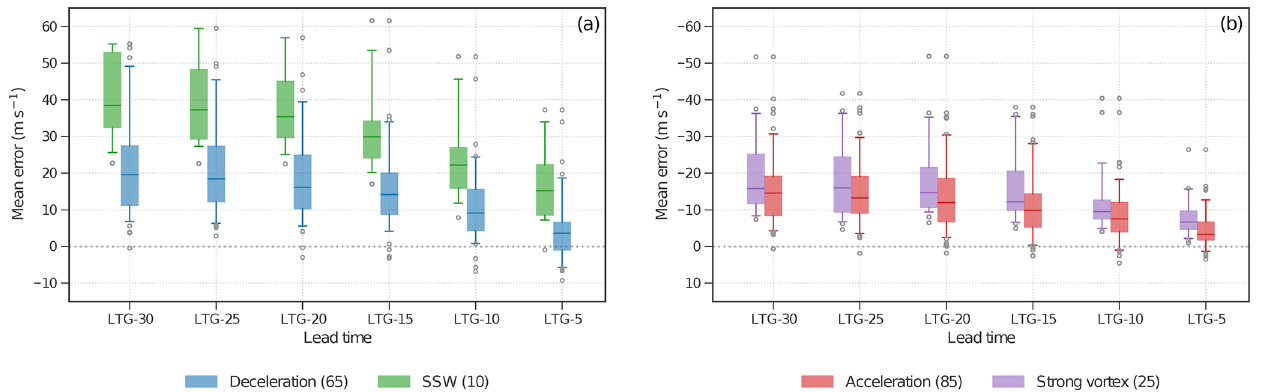
Figure 1. Mean error in the magnitude ((cid:49)u) of (a) deceleration events (blue) and SSW events (green) and (b) acceleration events (red) and strong vortex events (purple) for all LTGs. The y axis for acceleration events (b) is flipped for a more convenient comparison to deceleration events. The box extends from the 25th to the 75th percentiles of the mean error of the events, with a horizontal line at the median. The whiskers extend from the 5th to the 95th percentiles. Outliers are plotted as open grey circles. The numbers in brackets correspond to the number of events in total for each event type in reanalysis.